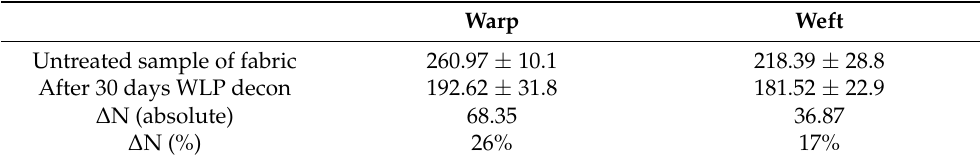
Table 3. Tearing strength (N) values with expanded uncertainty with 95% confidence, performed in accordance with ASTM D2261 [32].